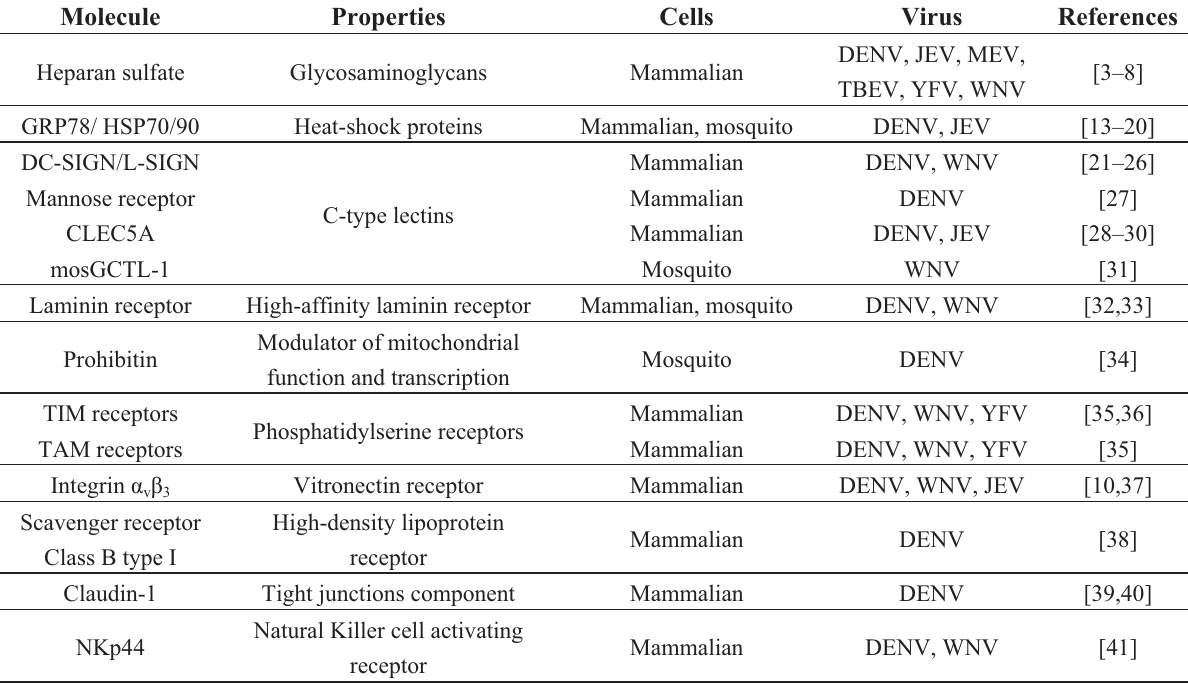
2.1. Dendritic Cell-Specific Intercellular Adhesion Molecule-3-Grabbing Non-Integrin